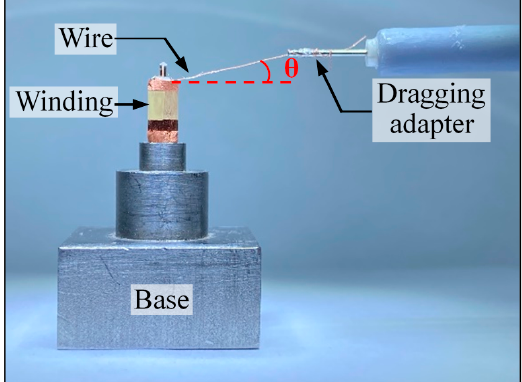
Figure 13. The partial enlargement of the area is marked by a red box in Figure 10, and it shows the rule of measuring the maximum pulling force on wires.